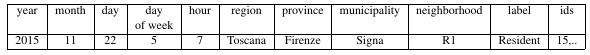
Table 3. Structure of the records stored in the distributed data storage